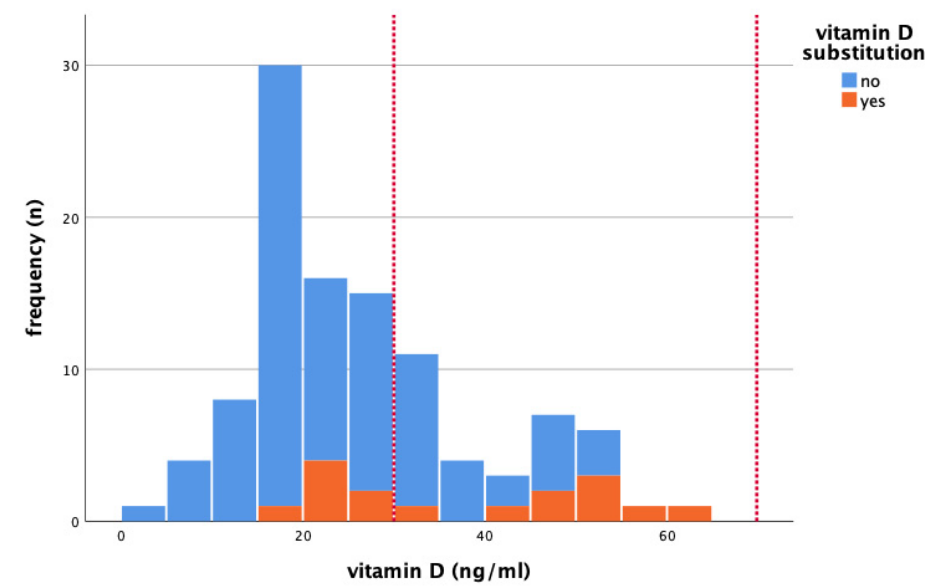
Figure 1. Serum 25-hydroxyvitamin D (25(OH)D) levels (ng/mL) at baseline visit in patients with and without vitamin D substitution. Reference for standard values: 30–100 ng/mL (see area in dashed red lines). ( n ) = absolute frequencies.